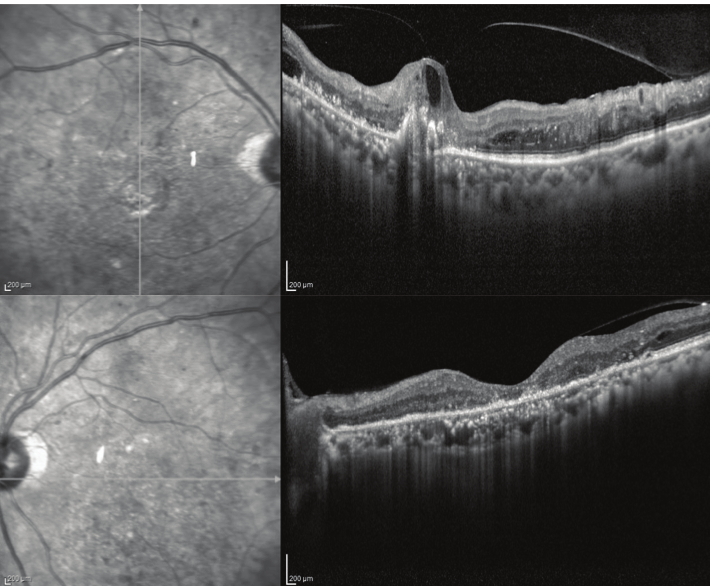
Figure 5. Optical coherence tomography of the right (above) and left (below) eyes following systemic treatment for multiple